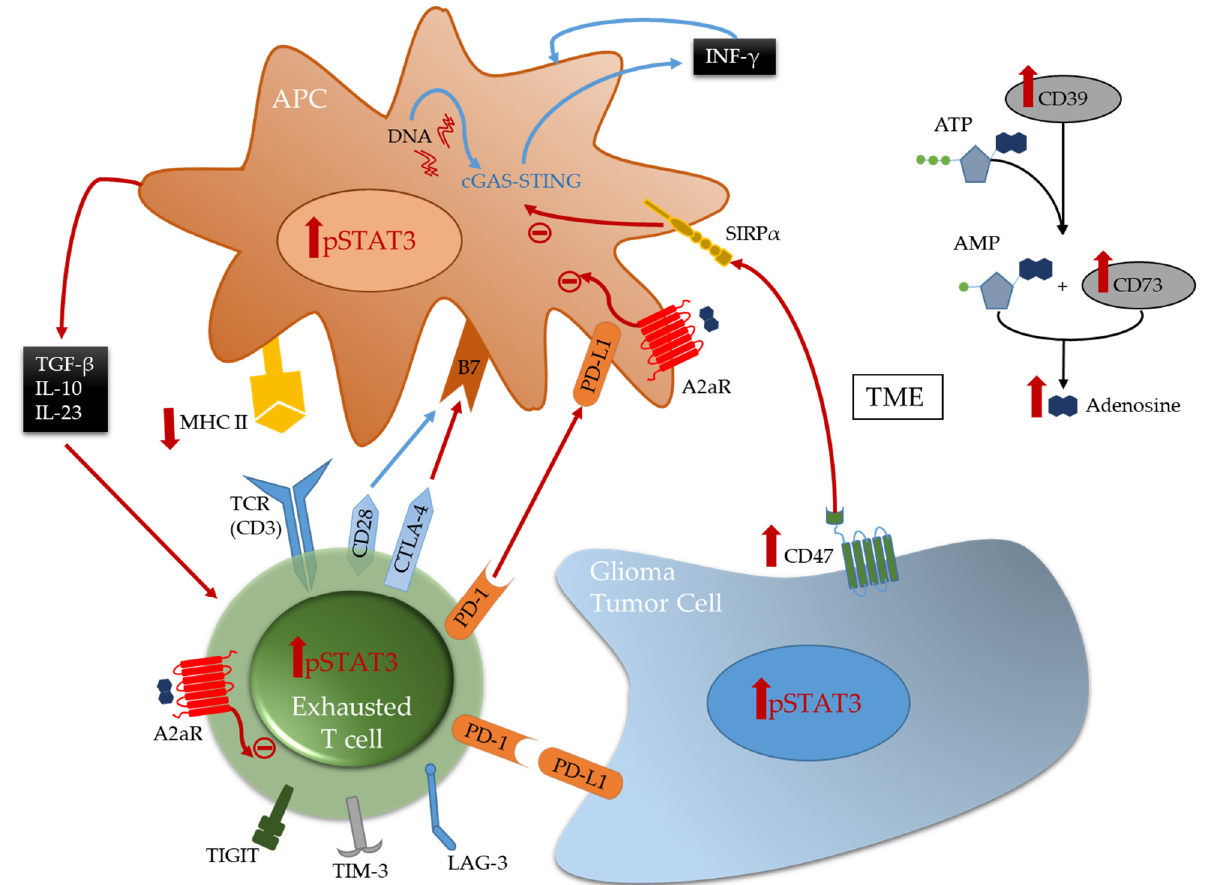
Figure 1. Immunosuppressive cross-talk between the immune system and glioma tumor cells. This figure summarizes the different immune checkpoints and cellular pathways associated with T cell exhaustion and inducing the immunosuppressive phenotype of antigen presenting cells (APC). Expression of CTLA-4 immune checkpoint on the T cell surface and its binding to B7 (CD80/CD86) on the APC surface, competes with CD28 thereby blocking T cell activation. In addition, the expression and upregulation of various immune checkpoints such as PD-1, TIM-3, and LAG-3 on the T cell surface triggered by repeated exposures to tumor antigens induces T cell exhaustion. Upregulation of immune checkpoints on immune and glioma cells can be induced by the upregulation of nuclear p-STAT3 known to be a molecular hub for the induction of immunosuppression. pSTAT3 downregulates the major histocompatibility II (MHC II) on the APC surface and induces the secretion of immunosuppressive cytokines like TGF- β , IL-10, and IL-23 (known to shift T cells differentiation to T-regs) that inhibit T cell activation and create an immunosuppressive environment. Glioma cells can express CD47 that binds to the SIRP α receptor on the APC surface thereby impeding phagocytosis. The cGAS-STING pathway senses DNA in the cytoplasm thereby stimulating the immune system by secretion of pro-inflammatory INF- γ favorizing immune cells activation and a macrophage pro-inflammatory phenotype shift. The presence of both CD39 and CD73 in the TME triggers the production of adenosine which binds to the A2aR receptor expressed on the surface of the immune cells thereby inducing immunosuppressive pathways rendering the immune system tumor